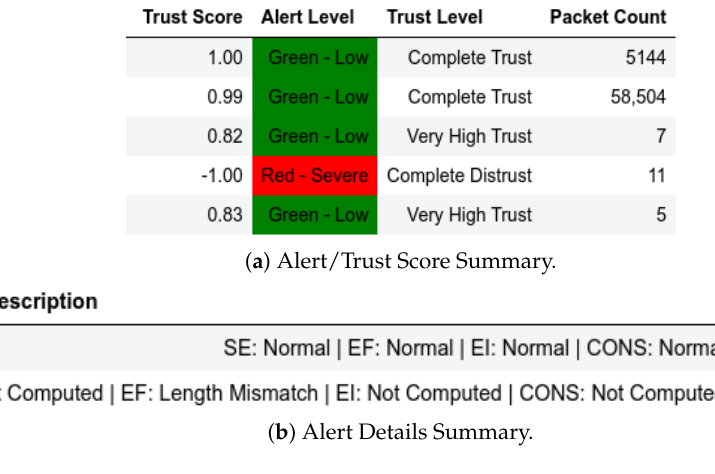
Figure 23. Server: ATENA H2020 dataset external test- H m in MitM capture.